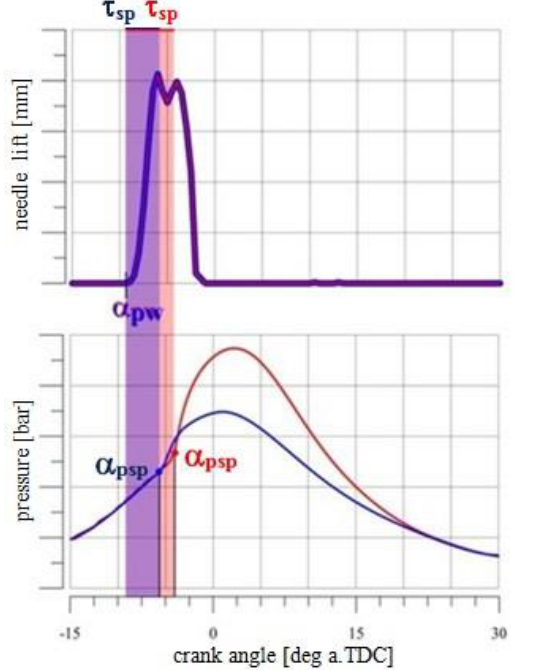
Fig. 5. Maximum combustion pressure (p s.max ) at selected duty points of the engine for the four tested